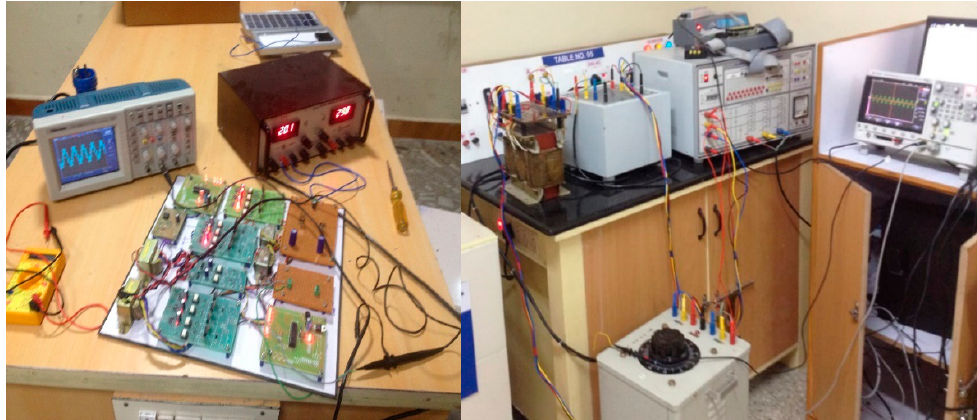
12 of 16 Figure 10. Simulation value of power loss calculation of switches.